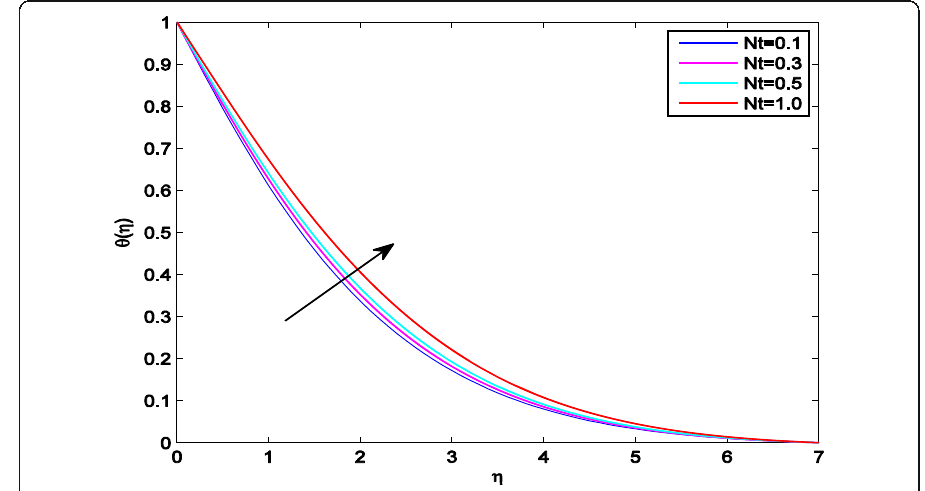
Fig. 14 Temperature graph for various values of